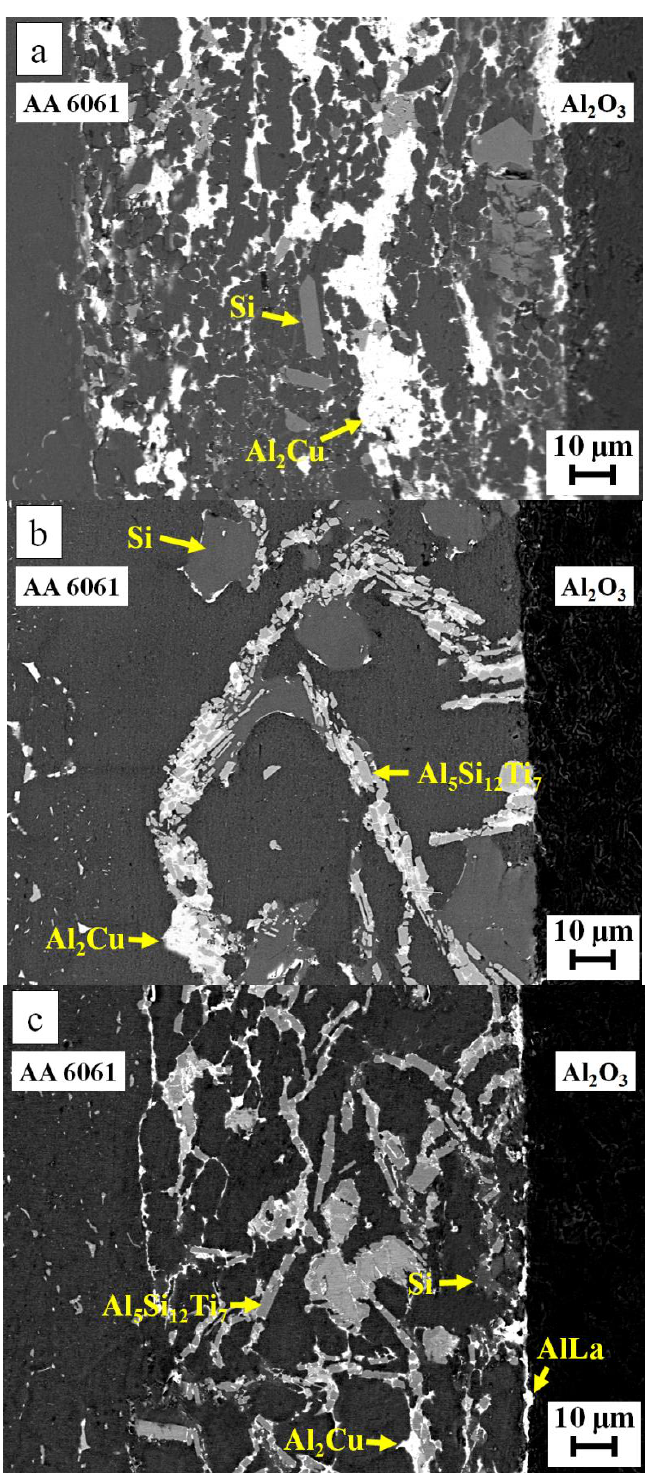
Figure 9. The microstructures under BSE mode of the AA6061/alumina joints with ( a ) Al10.8Si10Cu, ( b ) Al10Si10Cu4Ti and ( c ) Al10Si10Cu4Ti0.1RE filler alloys after brazing at 530 °C for 10 min. The joint shear strengths of the AA6061/alumina joints with Al10.8Si10Cu, Al10Si10Cu4Ti and Al10Si10Cu4Ti0.1RE filler alloys are shown in Figure 10. The joint with the Al10.8Si10Cu filler alloy separated at the beginning of the shear test, so the joint shear strength was not obtained. Although, the Al10.8Si10Cu filler alloy can be spread on the alumina under a small pressure during the joining process, and there is no obvious